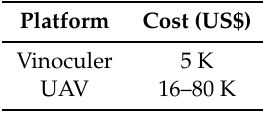
Table 1. Cost comparison between Vinoculer and 8 UAVs surveyed. The prices do not include any phenotyping